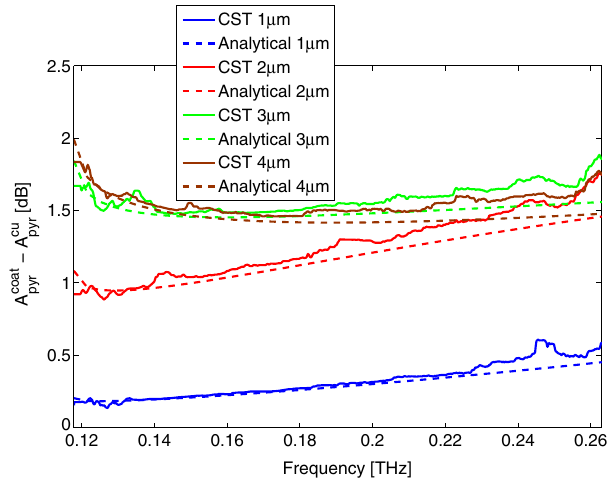
FIG. 9. Pyramidal transitions: relative attenuation of the sum of the first two modes on the slab for different coating thicknesses ¼ 3 . 5 × 10 5 S = m. Comparison between analytical with σ coat formulas (dashed line) and CST frequency domain simulations (full line).